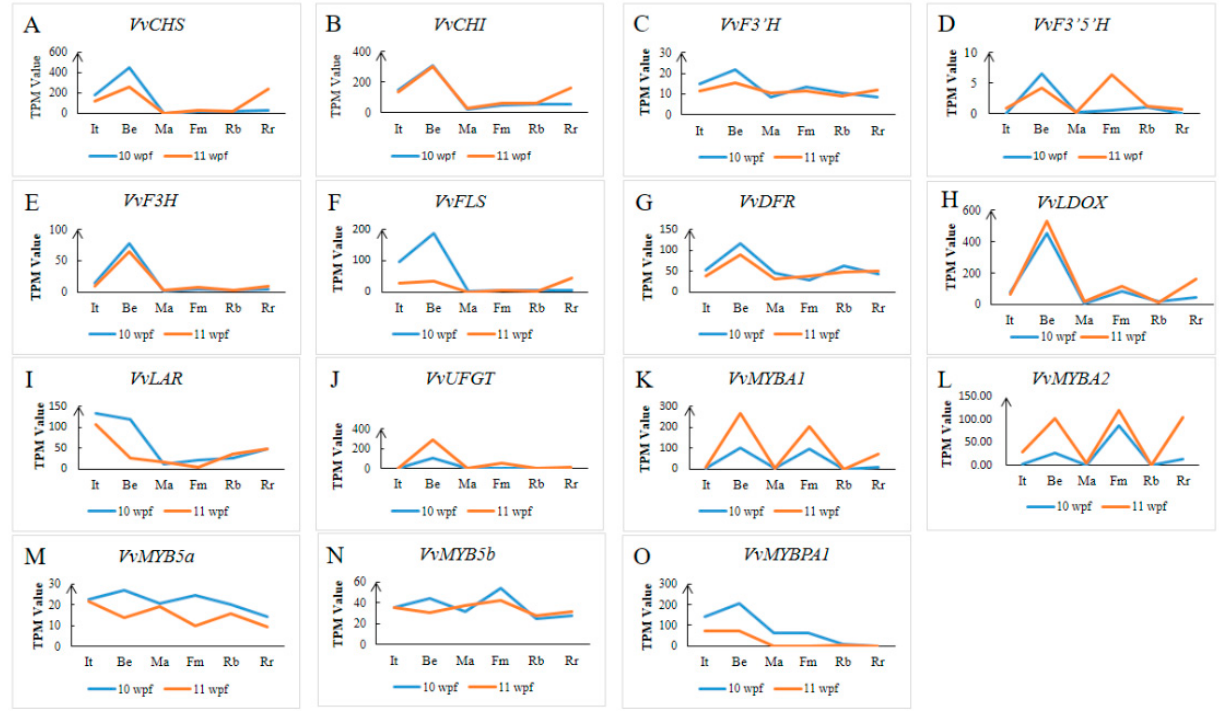
Figure 5. Anthocyanin synthesis structure gene and regulatory gene expression analysis of six vari- eties. ( A ) CHS , chalcone synthase; ( B ) CHI , chalcone isomerase; ( C ) F3 ′ H , flavonoid 30-hydroxylase; ( D ) F3 ′ 5 ′ H , flavanone3 ′ ,5 ′ -hydroxylase; ( E ) F3H , flavanone 3-hydroxylase; ( F ) FLS , flavonol synthase; ( G ) DFR , dihydroflavonol 4-reductase; ( H ) LDOX , leucoanthocyanidin dioxygenase; ( I ) LAR , leucoanthocyanidin reductase; ( J ) UFGT , anthocyanidin 3- O -glucosyltransferase; ( K – O ) MYBA1, MYBA2, MYB5a, MYB5b, MYBPA1 , transcription factor encode genes, belonging to the R2R3 Myb family, which controls the last steps in the anthocyanins biosynthesis pathway.